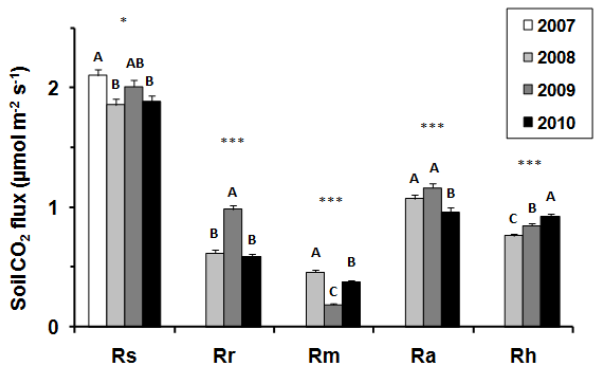
Fig. 5. Annual average rates of soil respiration ( R s ) , and contribu- tions from roots ( R r ) , mycorrhizal hyphae ( R m ) , autotrophic ( R a = R r + R m ) and heterotrophic soil fluxes ( R h ) at the Straits Enclo- sure, Alice Holt forest from 2007 to 2010. Averages ± SE ( n = 4). Statistically significant differences between years for each compo- nent are indicated with different letters, calculated from Tukey’s post-hoc test, with overall ANOVA P -values shown (* P < 0 . 05; ** P < 0 . 01; *** P < 0 .